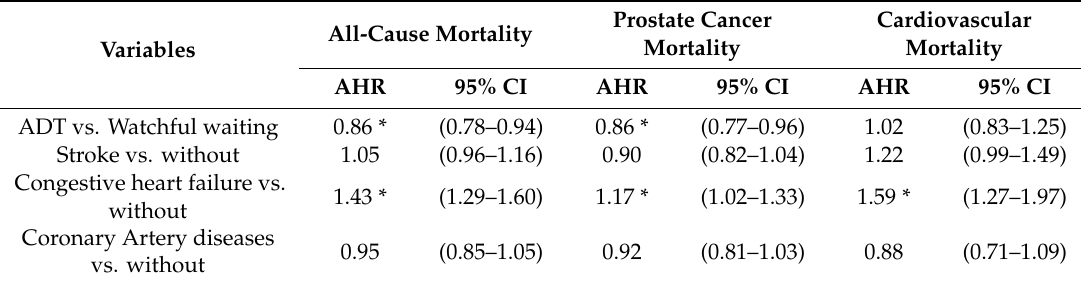
Table 2. Risk of all-cause, prostate cancer, and cardiovascular mortality associated with androgen deprivation therapy (ADT) and major cardiovascular comorbidities presented at the baseline in men with metastatic prostate cancer ( N = 3835). Prostate Cancer Cardiovascular All-Cause Mortality Mortality Mortality Variables AHR 95% CI AHR 95% CI AHR 95% CI ADT vs. Watchful waiting Congestive heart failure vs. Coronary Artery diseases